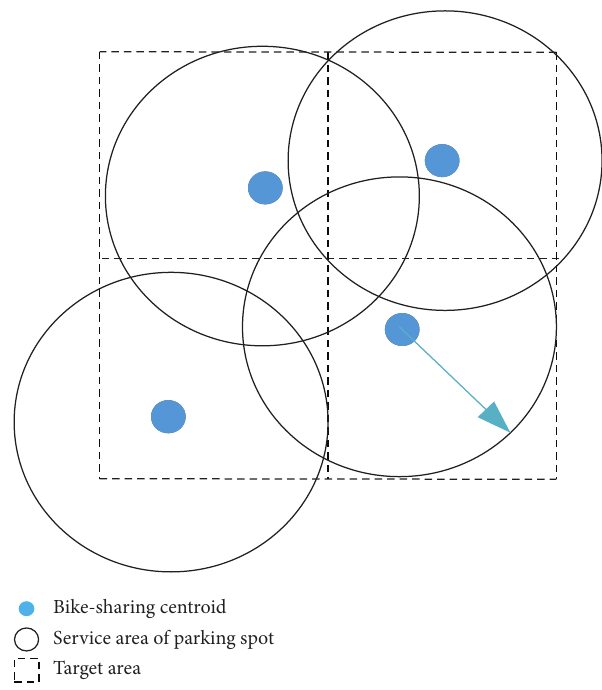
Figure 1: Diagram of the service scope of the bike-sharing parking spots.